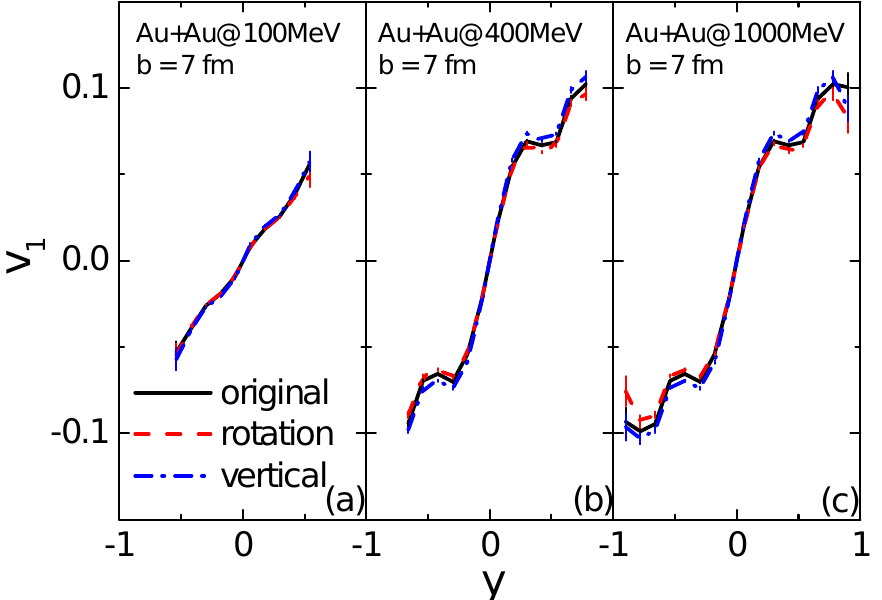
Figure 7. Rapidity dependence of the directed flow of free nucleons from three collision prescriptions in non-central Au+Au collisions at E lab = 100 ( a ); 400 ( b ); and 1000 ( c ) AMeV.